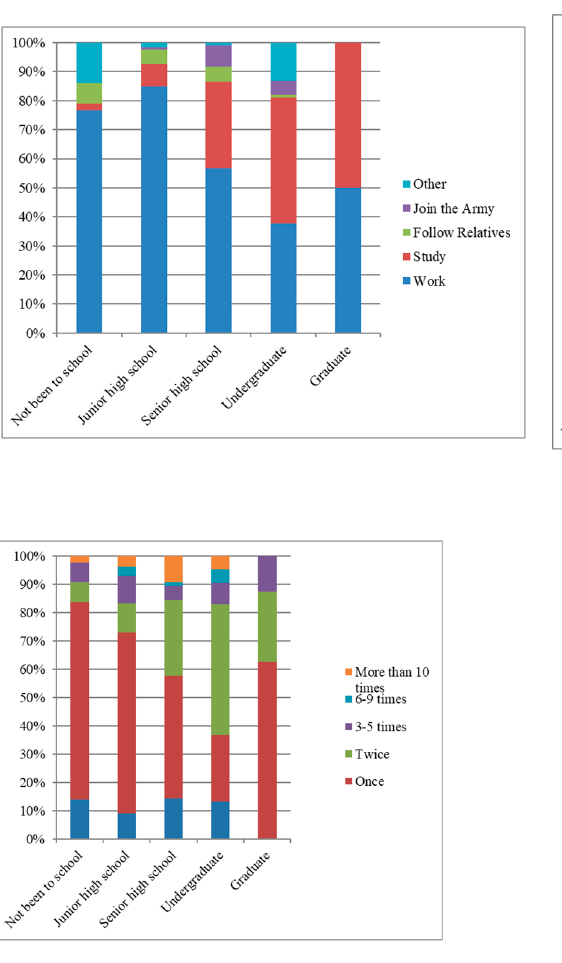
Figure 4. Various reasons for leaving home, migration destinations, and return home frequencies of different education groups.